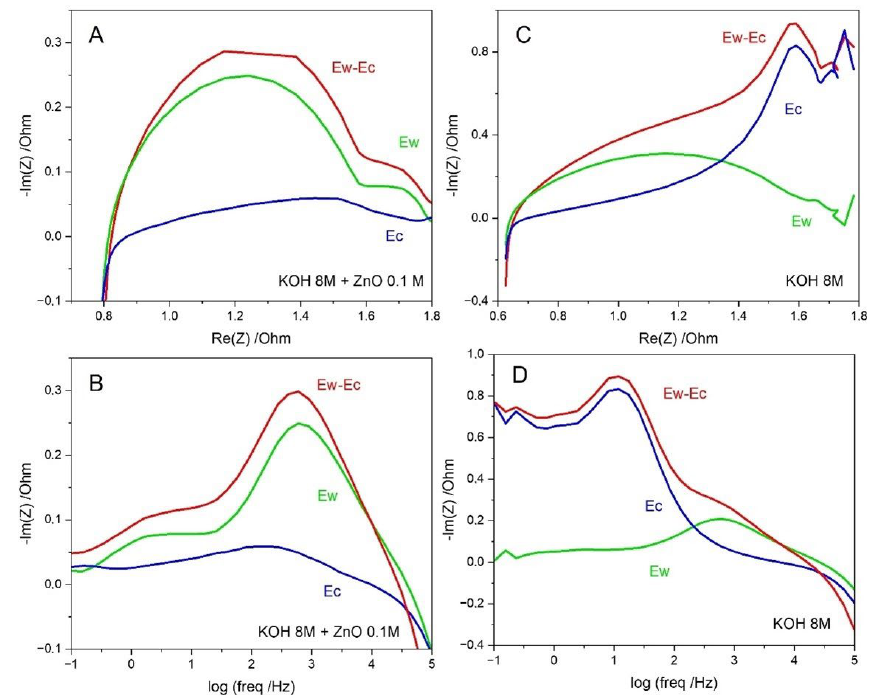
Figure 7. Nyquist ( A ) and the -Im(Z) vs. log (freq) ( B ) obtained during the charging process of a Zn/Bi 2 O 3 battery using 8 M KOH + 0.1 M ZnO electrolyte. Nyquist ( C ) and the -Im(Z) vs. log (freq) ( D ) obtained during the charging process of a Zn/Bi 2 O 3 battery using 8 M KOH electrolyte. EIS measurements were carried out after recharging the battery 10 mAh. Ew–Ec (red), Ew (green), and Ec (blue) curves are included in all figures.